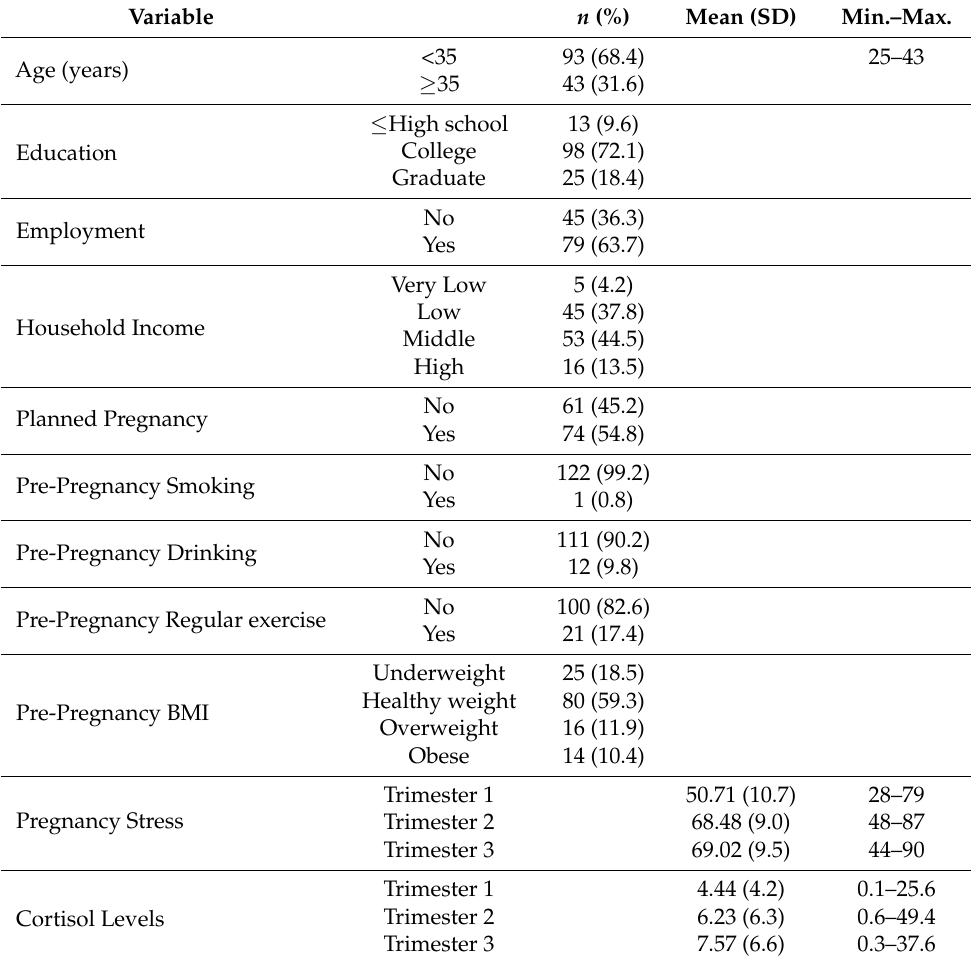
Table 1. Characteristics of participants ( n = 136).